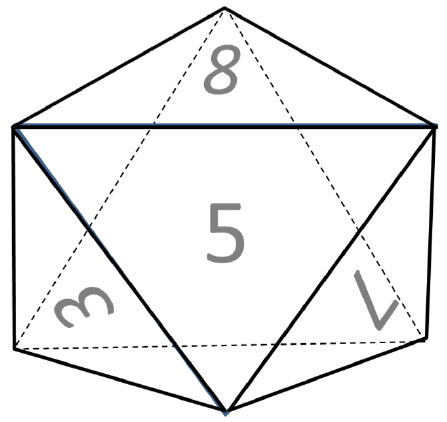
Figure 4. An 8 ‐ faceted die. Figure 4. An 8-faceted